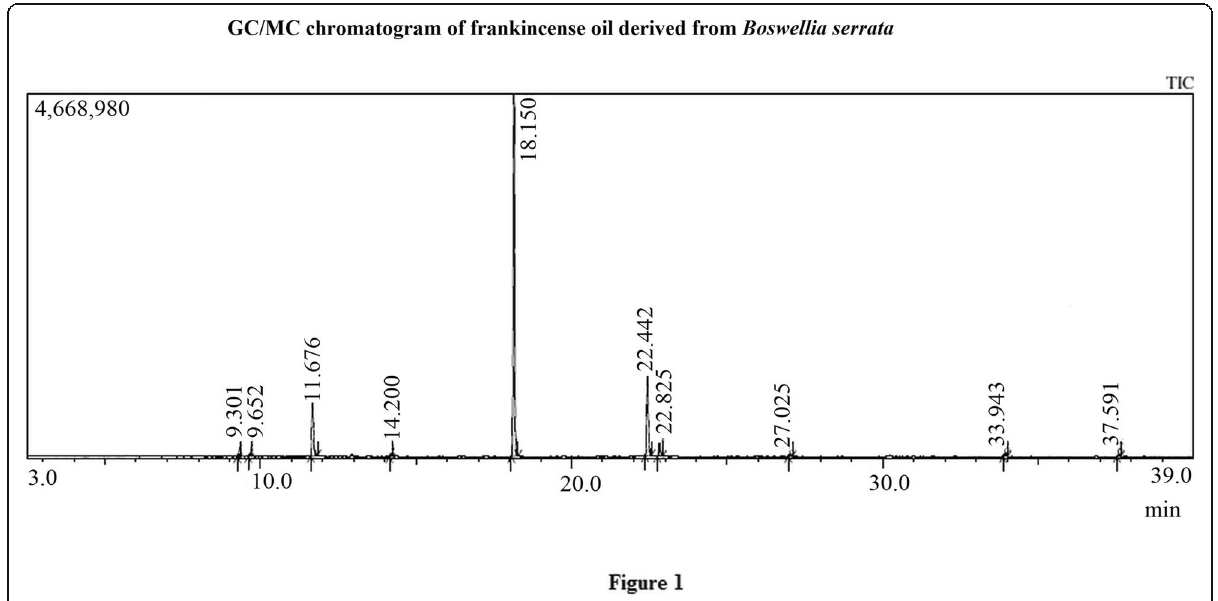
Fig. 1 Chromatogram of frankincense oil fractionation by GC/MC